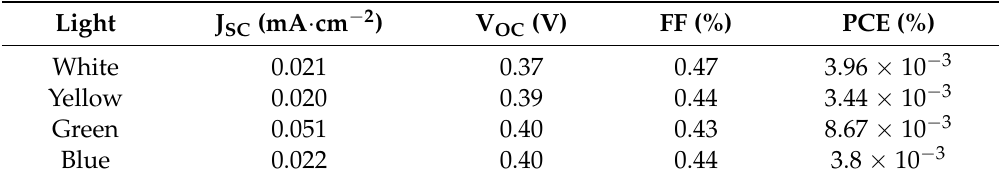
Table 2. Selected photovoltaic performance of a solar cell using alizarin yellow GG-CuCl 2 blended with PVA)/ITO under illumination for white, blue, yellow and green. Reprinted from [24] with permission of Elsevier.